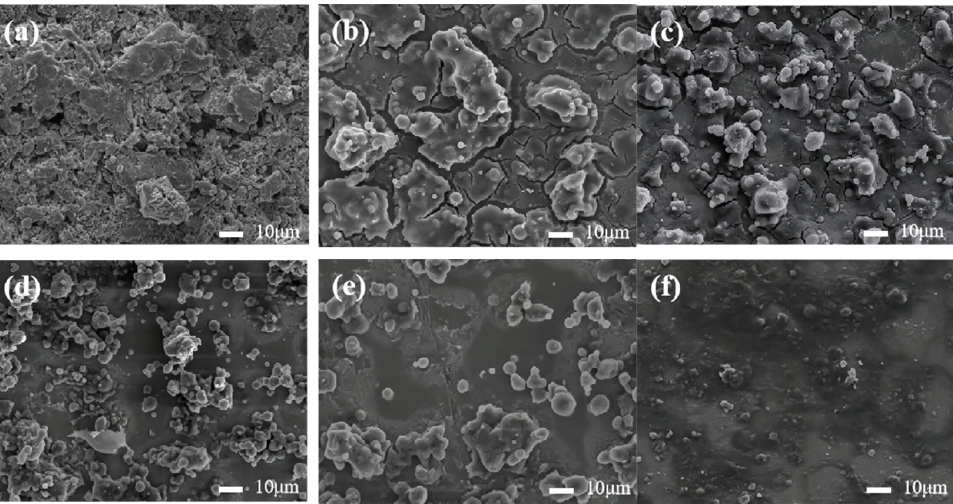
Figure 5. Microstructure of coating with different molar ratios of PDMS and TEOS. ( a ) Uncoated wall surface. ( b ) n (PDMS):n (TEOS) = 0. ( c ) n (PDMS):n (TEOS) = 1:10. ( d ) n (PDMS):n (TEOS) = 1:5. ( e ) n (PDMS):n (TEOS) = 3:10. ( f ) n (PDMS):n (TEOS) = 2:5.